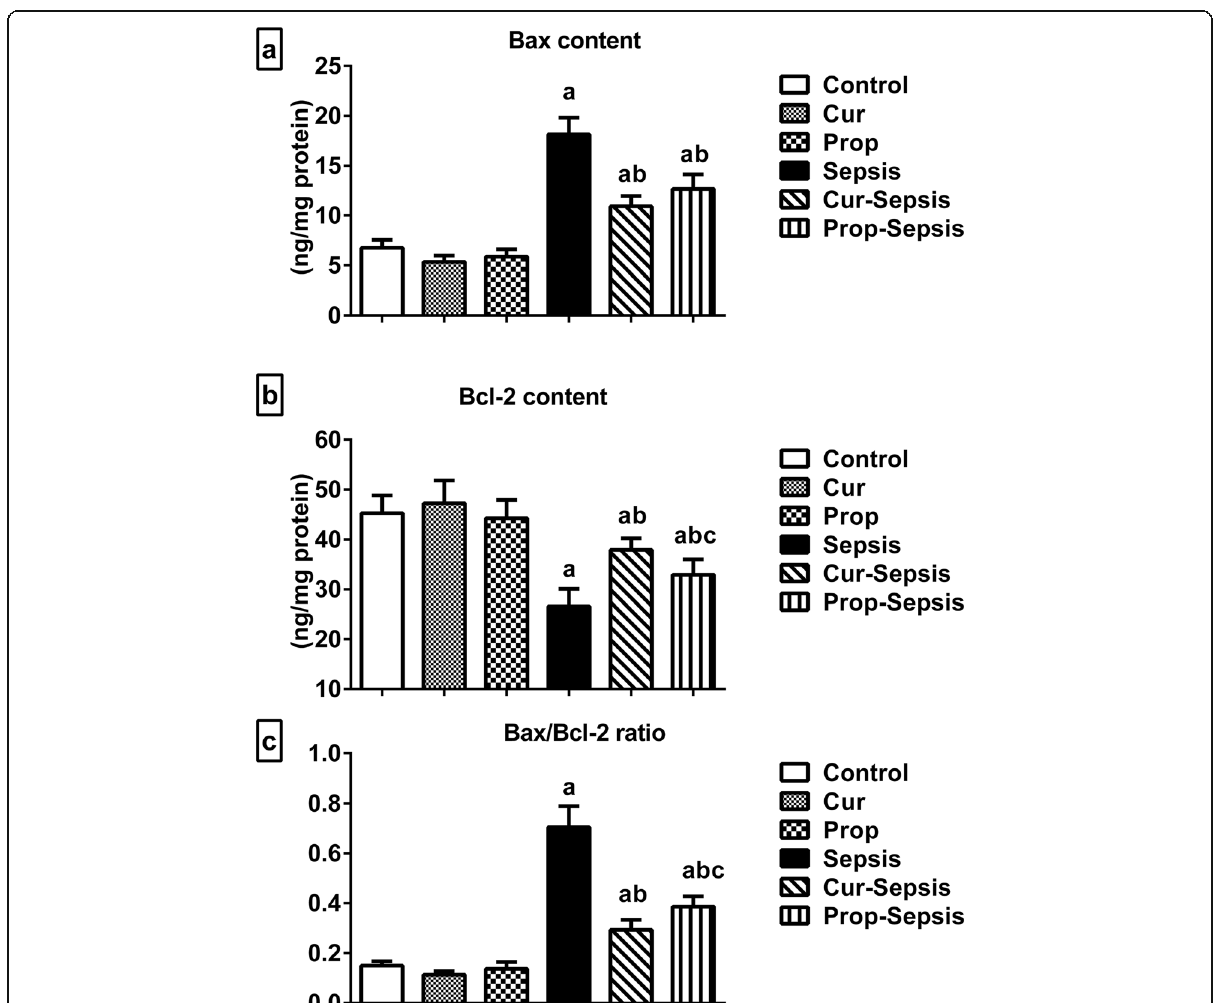
Fig. 4 The effect of either propolis (Prop) or curcumin (Cur) on a Bax, b BcL-2 contents, and c the Bax/BcL-2 ratio in kidney tissue after sepsis- induction in adult male rats. Data are expressed as mean ± S.E.M for 6 rats/group. a, significant difference from control group by one way ANOVA at P < 0.05; b, significant difference from SEP group by one-way ANOVA at P < 0.05; c, significant difference between cur and prop-sepsis and cur-sepsis groups by one-way ANOVA at P <